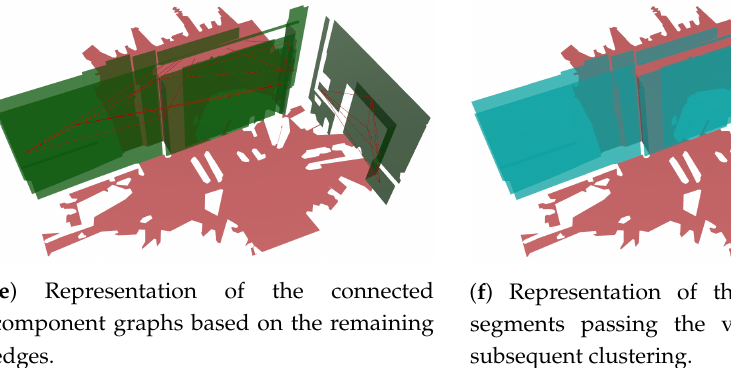
Figure 2. Workflow of the graph-based wall segments clustering depicting the consecutive steps. The wall segments are shown in green, floor segments in red, and graph edges in